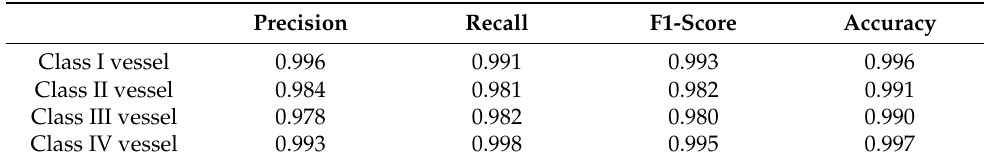
Table 4. Recognition results of camResNet.